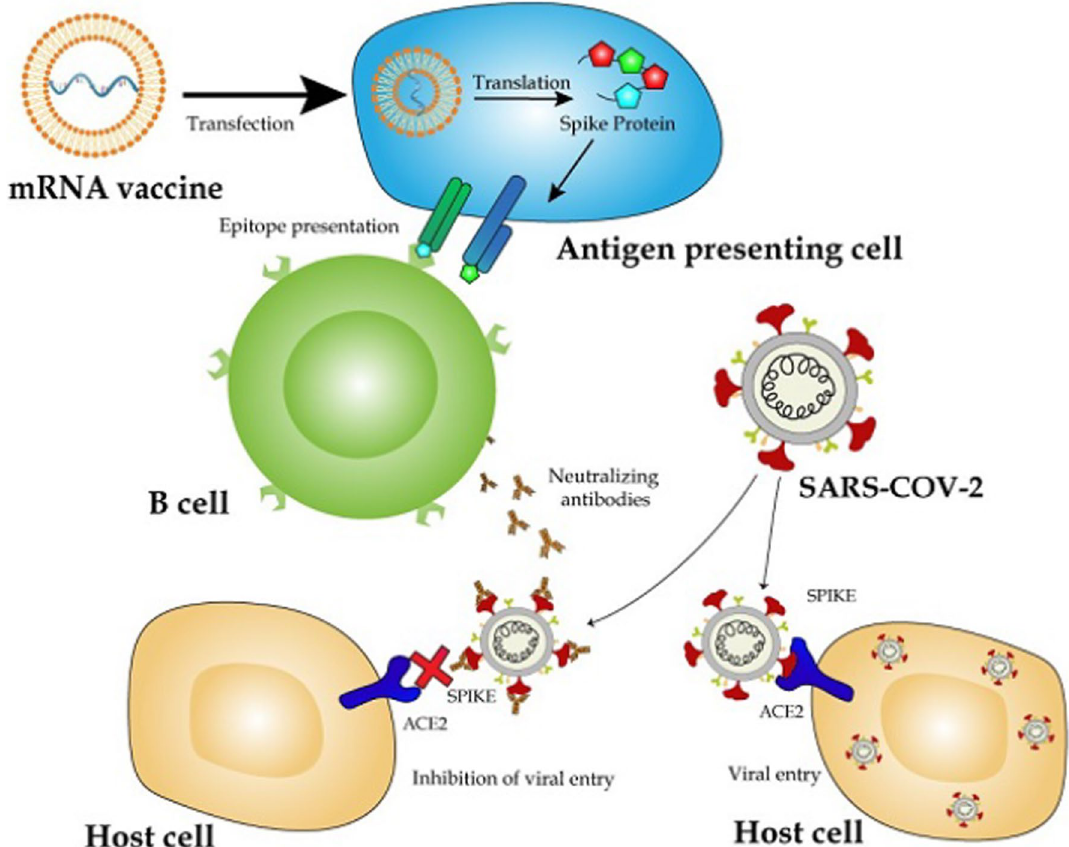
Fig. 1 mRNA vaccines for